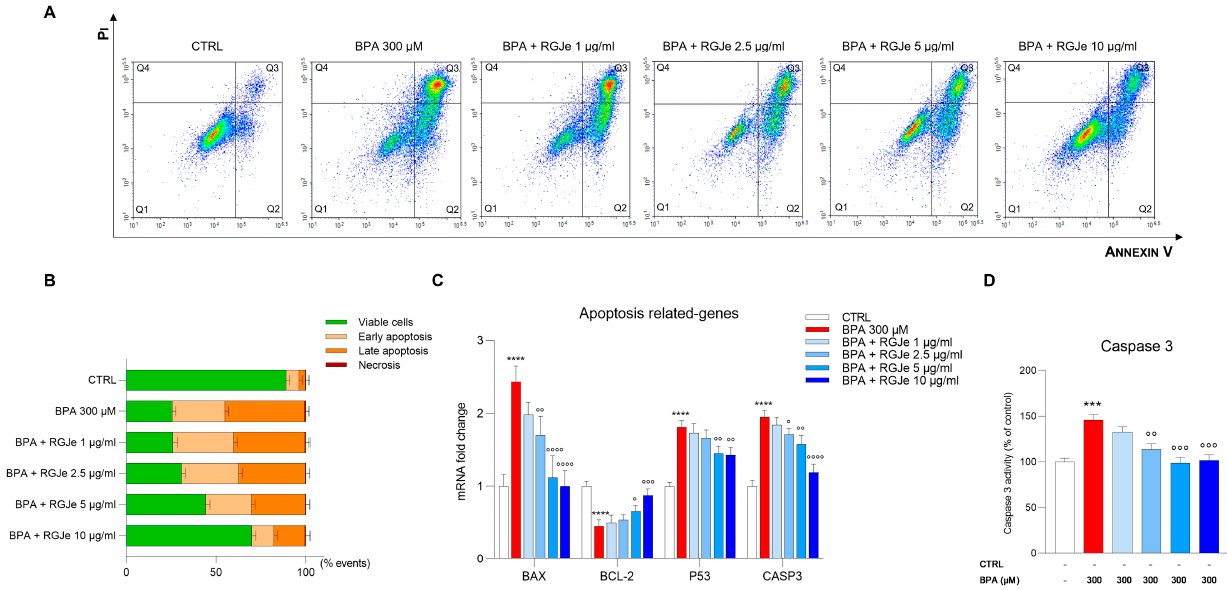
Figure 6. RGJe reduced the BPA-induced apoptotic cell death and modulated Casp3 enzymatic activity and apoptotic-related genes in HUVECs. Evaluation of apoptosis was performed cytofluorimetrically by the Annexin V-FITC/PI test ( A ). Representative Annexin V vs. PI dot plots are shown where necrotic (Annexin V − /PI+), late apoptosis (Annexin V+/PI+), viable (Annexin V − /PI − ), and early apoptosis (Annexin V+/PI − ) cells are in Q4, Q3, Q1, and Q2, respectively. The histograms report the percentage of cells for each quadrant, expressed as the mean ± SEM of three experiments in triplicate (n = 9) ( B ). The mRNA levels of apoptosis-related genes BAX, BCL-2, P53, and CASP3 were quantified via RT-PCR using the 2 − ∆∆ CT method. Data are expressed as n-fold change relative to the untreated cells, reporting the obtained values from three independent experiments performed in triplicate (n = 9) ( C ). Data of caspase 3 enzymatic activity are expressed as the percentage of the value detected in treated cells compared to the untreated ones and are displayed as the mean ± SEM of three experiments in triplicate (n = 9) ( D ). *** p < 0.001 and **** p < 0.0001 vs. CTRL; ◦ p < 0.05, ◦◦ p < 0.01, ◦◦◦ p < 0.001, and ◦◦◦◦ p < 0.0001 vs. BPA 300 µ